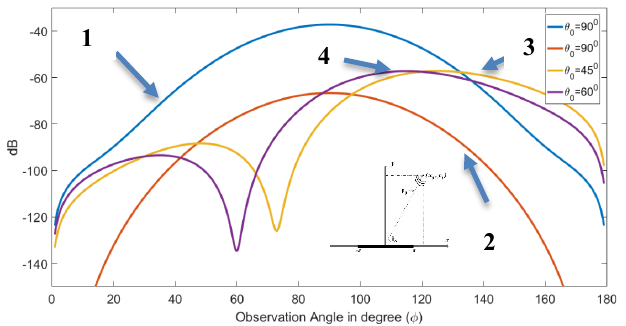
Figure 8: Bi-static Radar Cross Section for 𝜖 = 𝜋